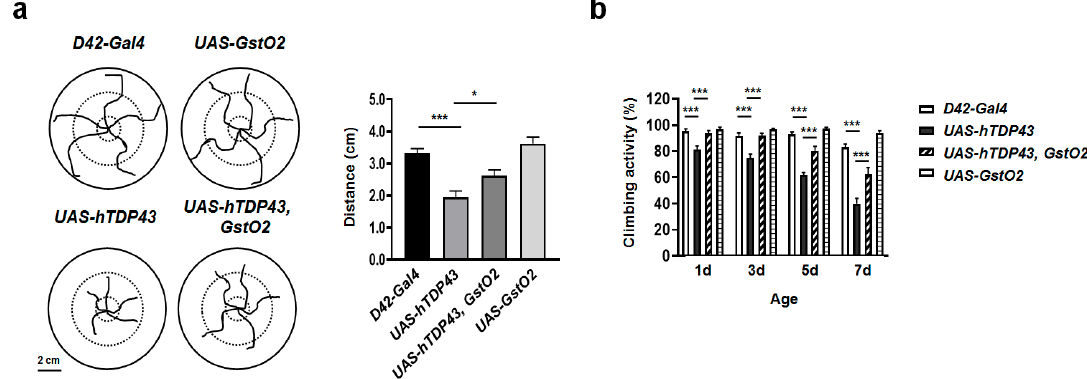
Figure 3. The up-regulation of GstO2 in motor neurons alleviated the motility deficits caused by hTDP-43. ( a ) Schematic illustration and quantification of larvae crawling traces from 60 s trials. The crawling distance of larvae overexpressing hTDP-43 decreased compared to the control larvae. Overexpression of GstO2 suppressed defective locomotive activity in hTDP-43-induced larvae. Overexpression of GstO2 alone had no effect on crawling activity. Statistical significance was determined using the unpaired Student t -test (* p < 0.05; *** p < 0.001, n > 10 for each genotypes). Error